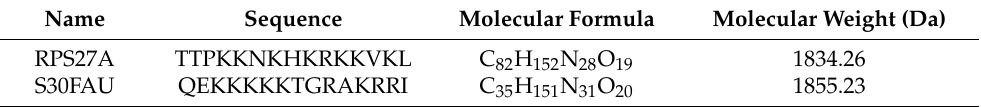
Table 2. Synthesis peptides used in this